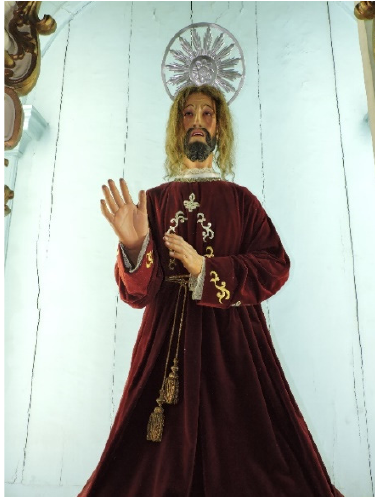
Figure 1. Agony in the Garden , in the Church of the Third Order of Mount Carmel in São Paulo. Polychrome wood sculpture (136 × 78 × 67cm), eighteenth century. Photo by Lia Brusadin, 28 De- cember 2016.